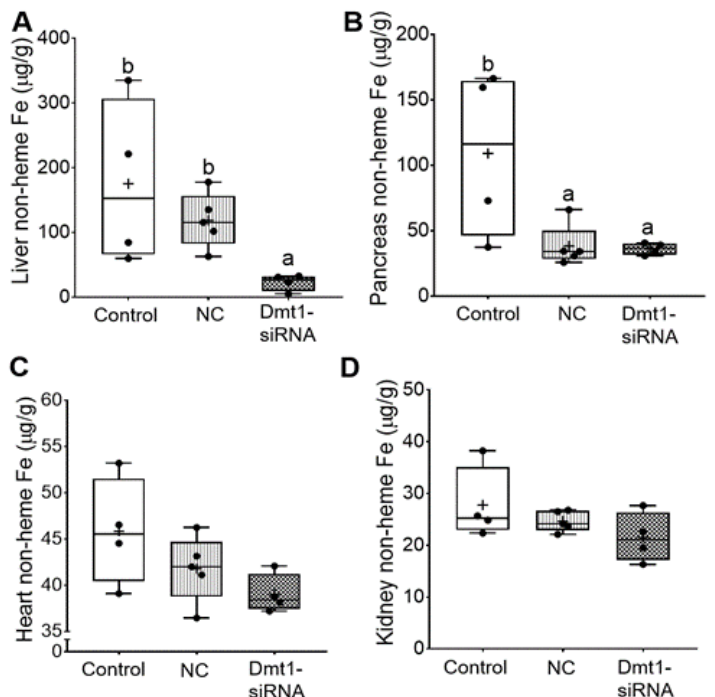
Figure 7. FA-GDLVs/siRNA administration decreased liver and pancreatic iron levels. Shown is non-heme Fe content in liver ( A ), pancreas ( B ), heart ( C ), and kidney ( D ). Data were analyzed by one-way ANOVA ( A – D ), followed by Tukey’s multiple comparisons test ( A , B ). Data are pre- sented as box plots for n = 4–5 mice per group. Groups labeled with different letters differ signifi- cantly. p = 0.0048 ( A ), p = 0.0264 ( B ). NC, negative control; + , mean value.